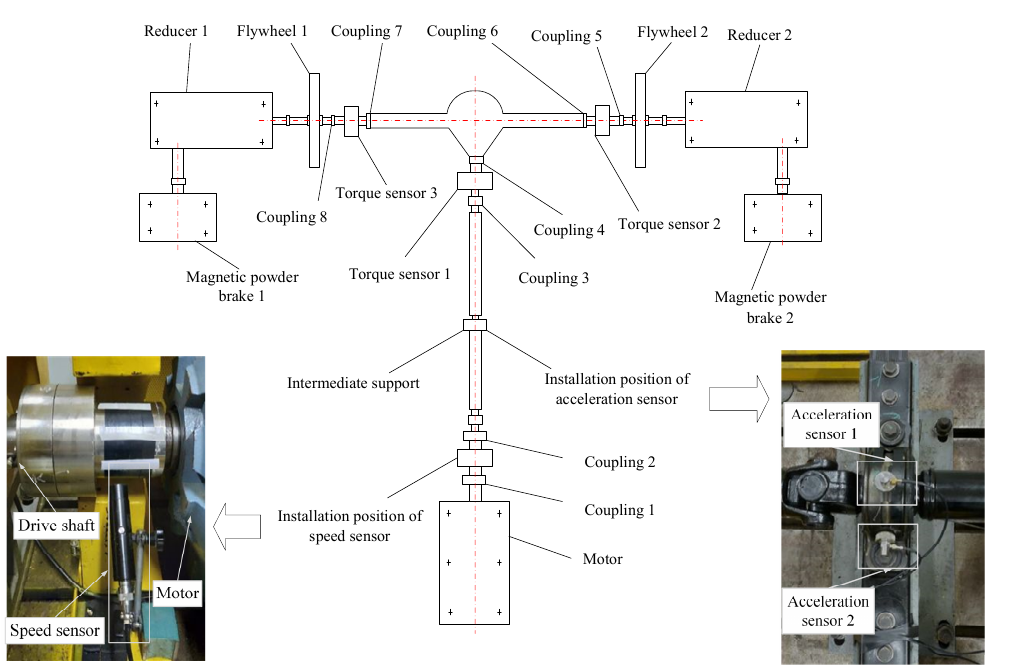
Figure 7. Configuration of the test rig. Table 4. Parameters of the test rig.